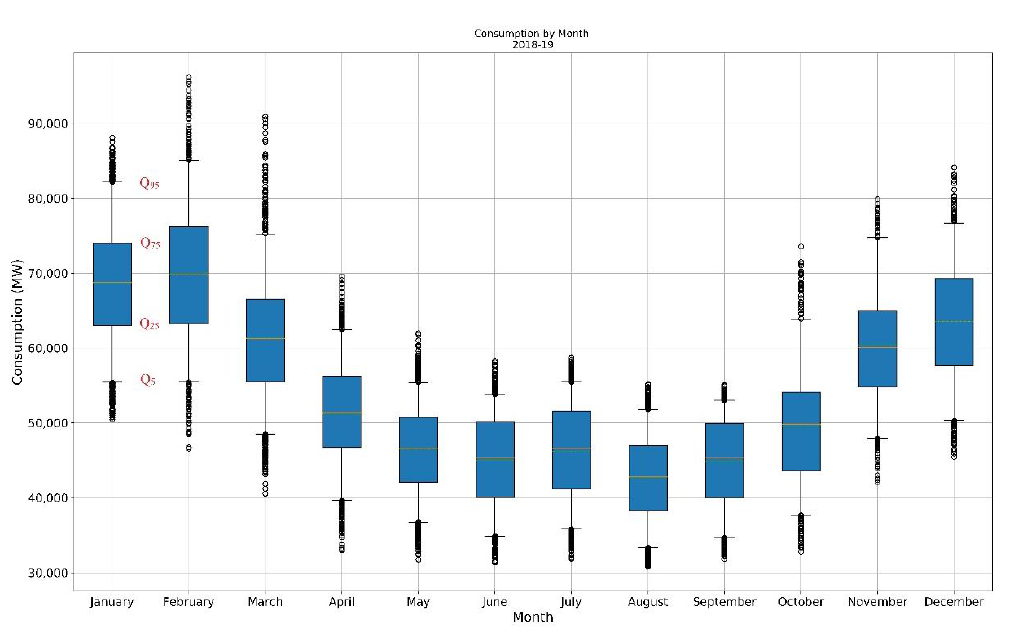
Figure 2. Monthly French energy demand for the period 2018–2019. Q x indicates the X data percentiles. The colored lines within the Q 25 and Q 75 quartile boxes represent the median (orange line) and the mean (dashed green line). Points below and above Q 25 and Q 75 are shown as well.